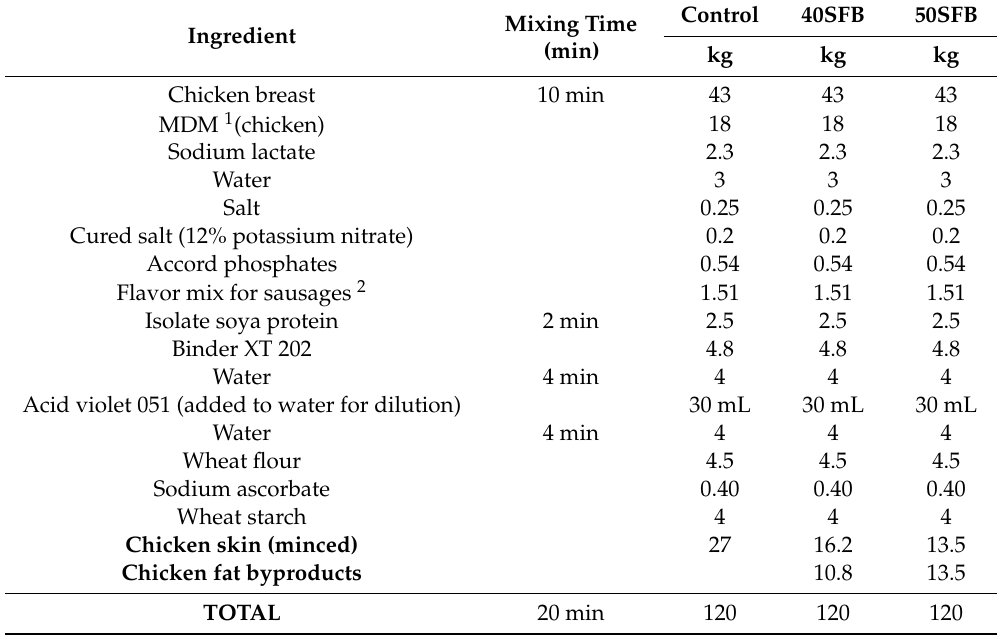
Table 1. Formulation of chicken sausages (40SFB: 40% substitution of chicken skin by fatty byproducts; 50SFB: 50% substitution of chicken skin by fatty